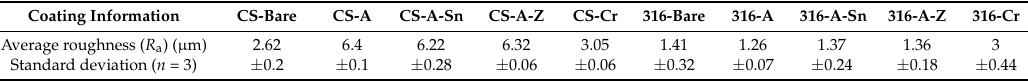
Table 3. Average roughness of the substrates after the high-temperature corrosive